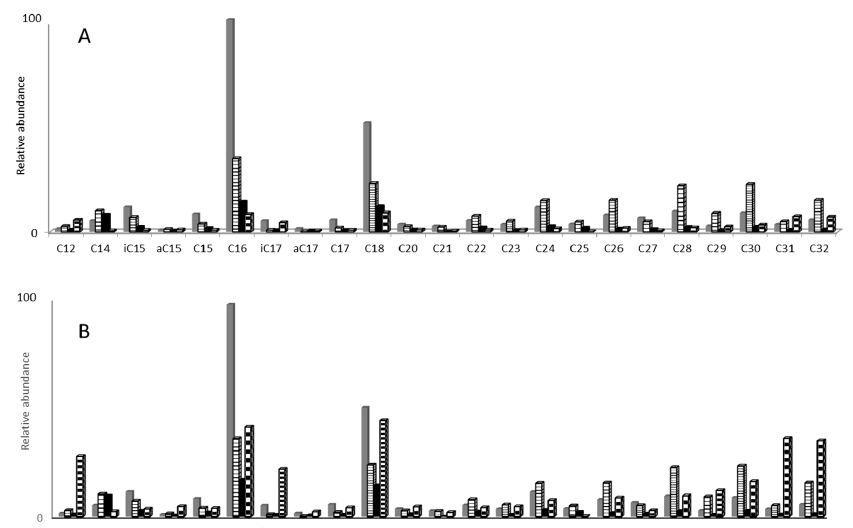
Figure 3. BF 3 /MeOH derivatization on 500 mL reference ( A ) and amended ( B ) soil solutions from 15 to 100 cm depth after a 40 °C evaporation step.